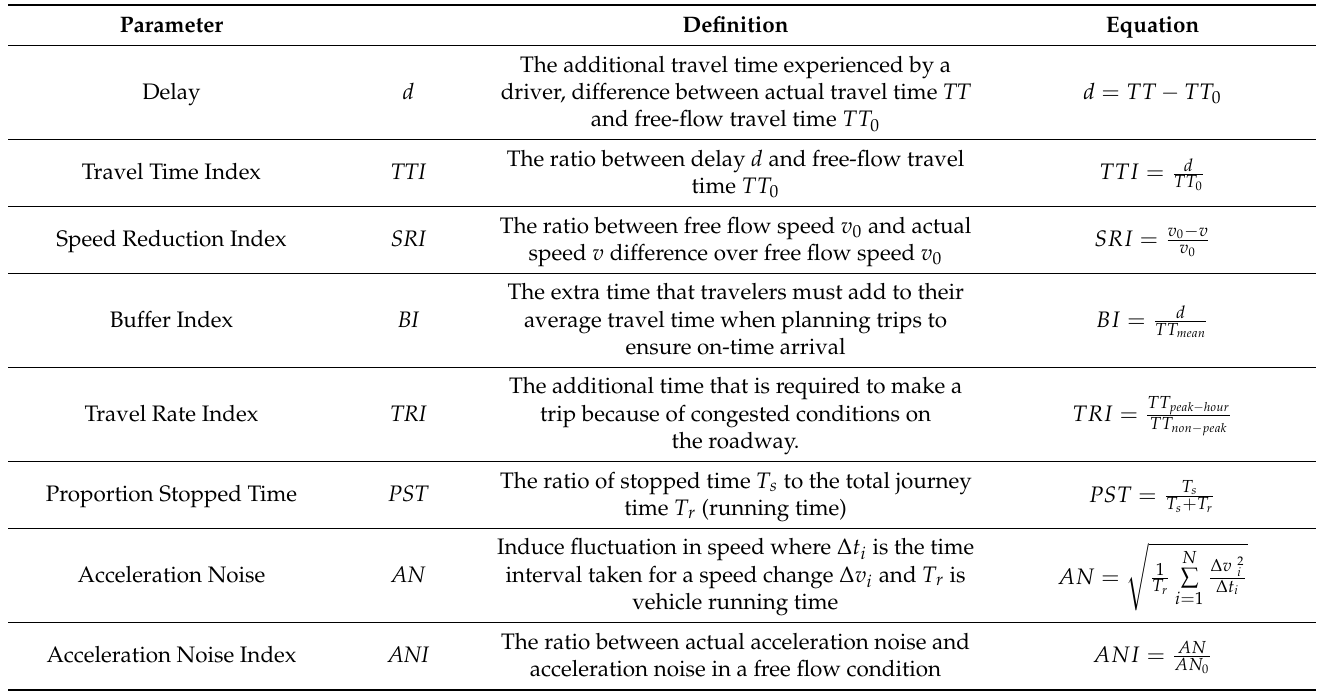
Table 2. Congestion Indexes or